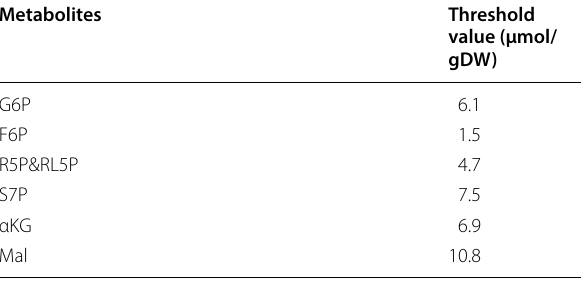
Table 3 Intracellular metabolite threshold values of A.